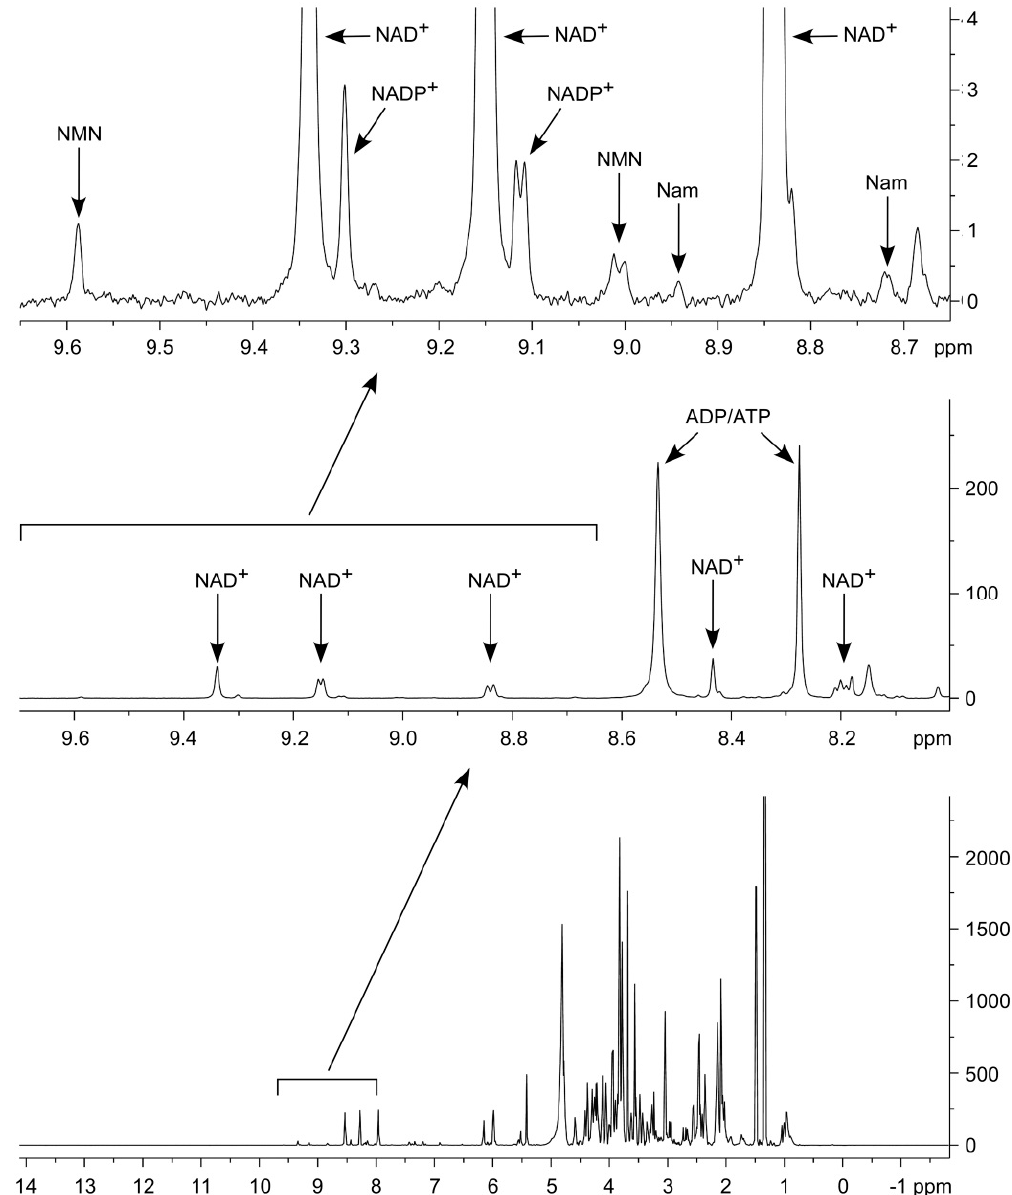
Figure 2. Detection of NAD + and its major intermediates in human cell extracts. Proton nuclear magnetic resonance spectrum of cell extract obtained from HEK293 cells cultivated in the presence of Nam. Spectral region containing peaks corresponding to NAD + and its major intermediates is expanded. The number of scans (nt) was 8192.